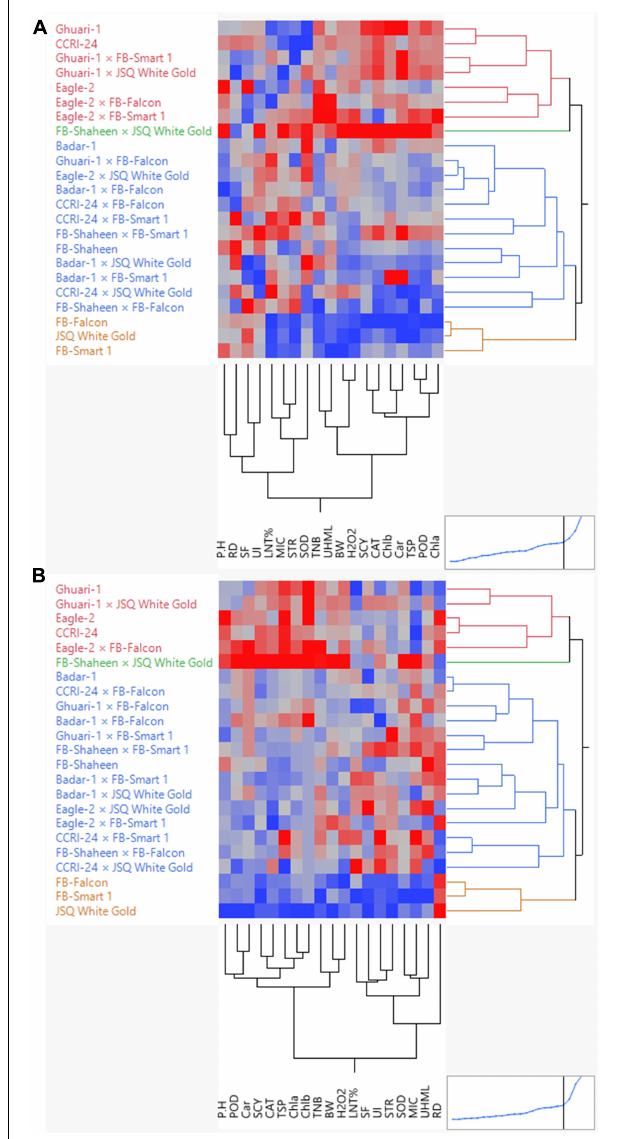
FIGURE 3 | Hierarchical clustering of 23 cotton genotypes for biochemical, yield, and fiber-related traits under normal (A) and high-temperature stress (B)